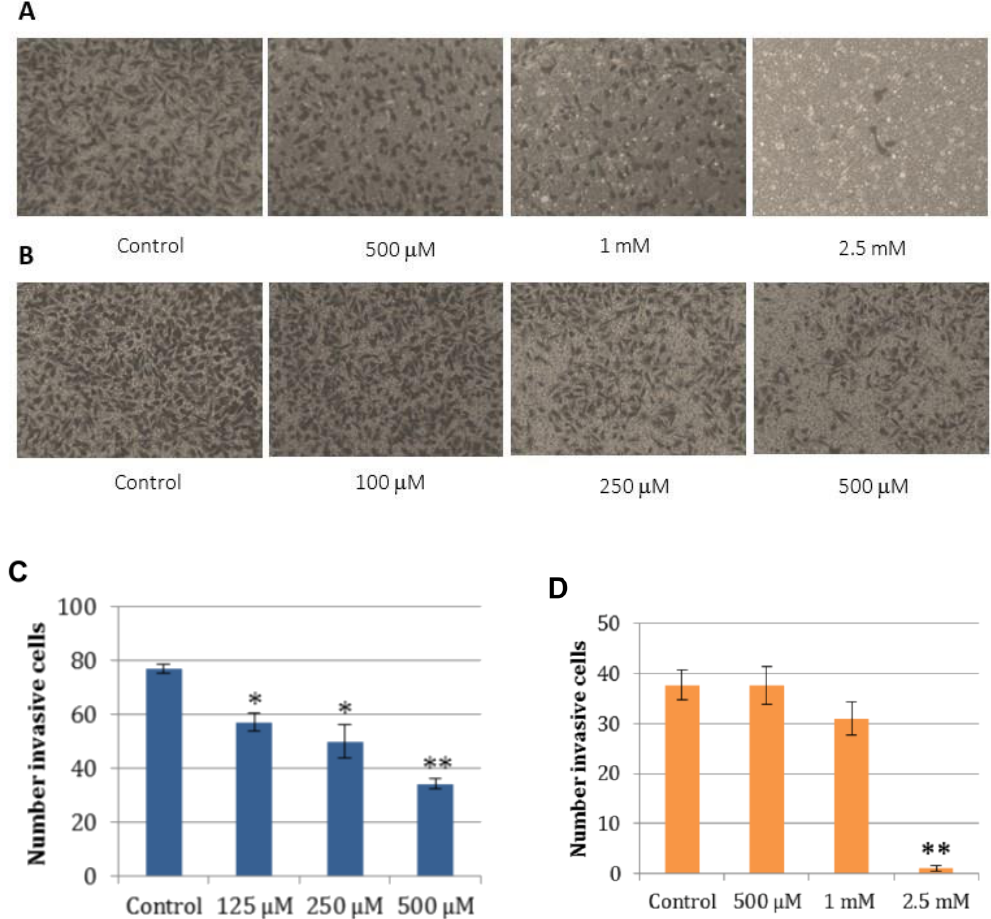
Figure 6. Inhibition of transwell invasion of WM266 cells by SeDG-Bn. WM266 cells were treated with ( A ) SeDG-Bn and ( B ) SeDG at the indicated concentrations and cells penetrating the matrix were fixed and stained after 24 h. Representative images of migrating cells stained with crystal violet are displayed at 10 × magnification. Quantitative data of the invasion assay in the presence of ( C ) SeDG-Bn and ( D ) SeDG are reported in the graphs. Data represent the mean ± SE of three individual experiments. ** p < 0.01 * p < 0.05